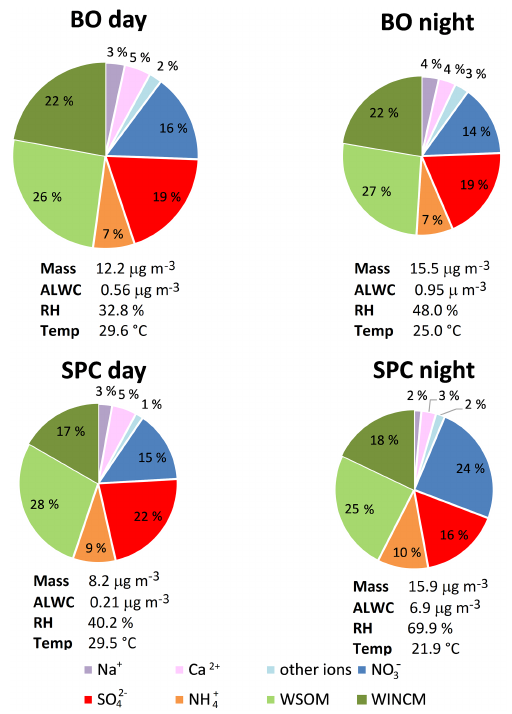
Figure 4. Average day and night PM 10 composition at BO and SPC during the campaign. “Other ions” include chloride, nitrite, potas- sium and magnesium. WSOM stands for water-soluble organic mat- ter, while WINCM for water-insoluble carbonaceous matter. Aver- age mass, ALWC, RH and temperature are indicated below each pie. The size of each pie chart is proportional to the total measured mass